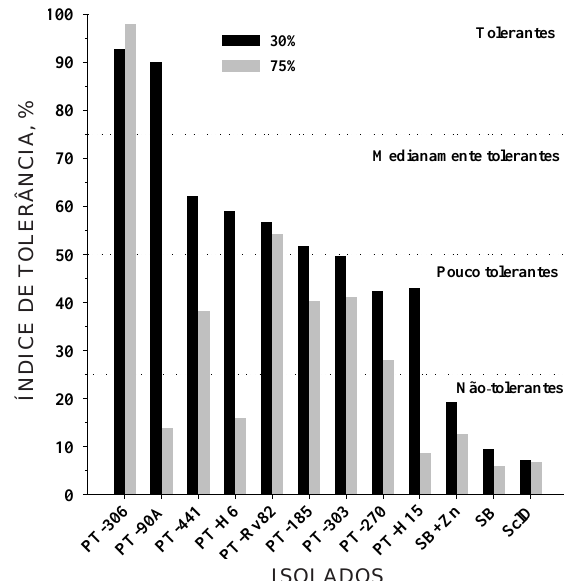
Figura 2. Índice de tolerância (IT%) e categorização de isolados de fungos ectomicorrízicos em meio MNM que continha mistura de solo e areia, com 30 e 75% de solo contaminado. IT% £££££ 25% = Não- tolerantes; 26 a 50% = Pouco tolerantes; 51 a 75% = Medianamente tolerantes; ‡‡‡‡‡ 76% =